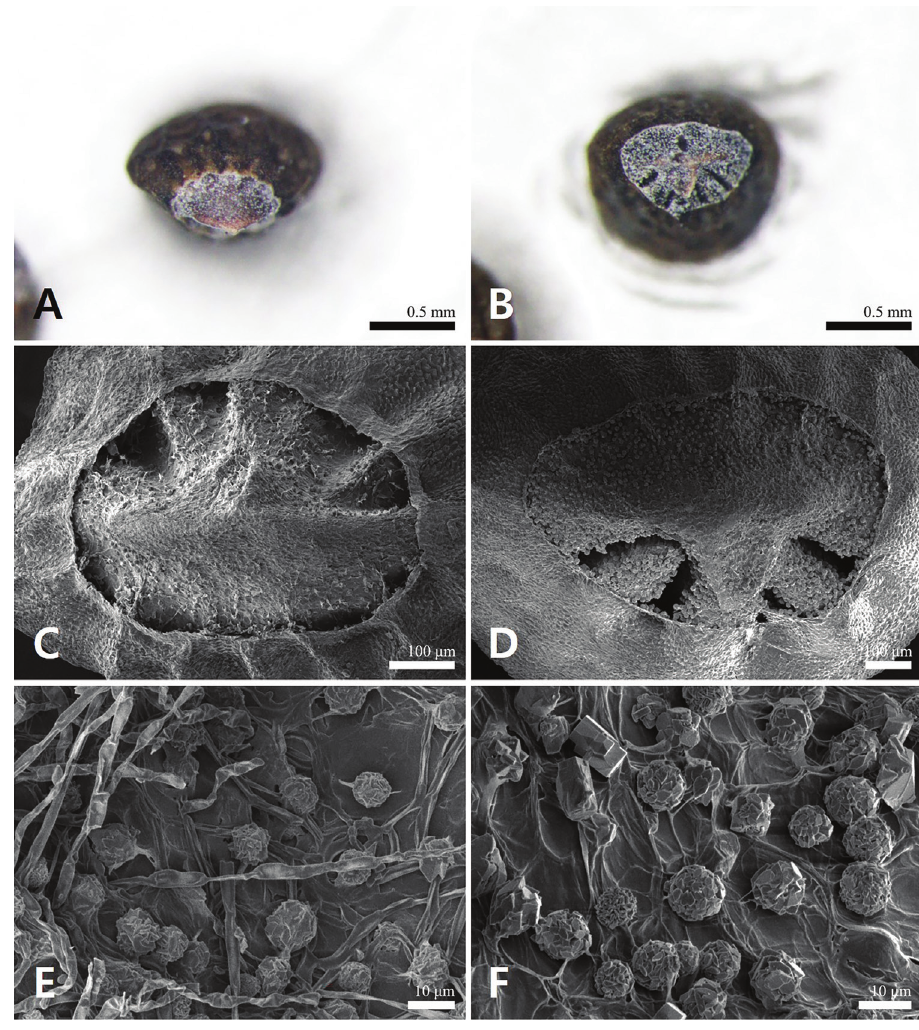
Figure 4. Stereo- and scanning electron microscope micrographs of abscission scar in Mosla dadoensis ( A, C, E ) and M. chinensis ( B, D, F